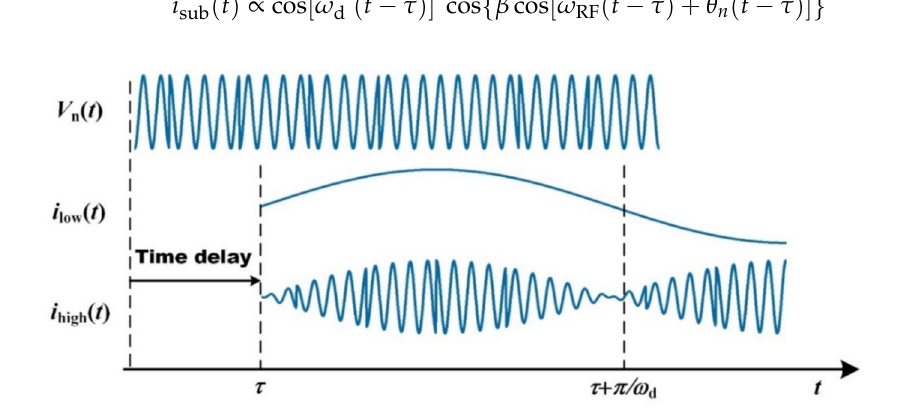
Figure 2. Schematic illustration of waveforms for V n ( t ), i low ( t ), and i high ( t